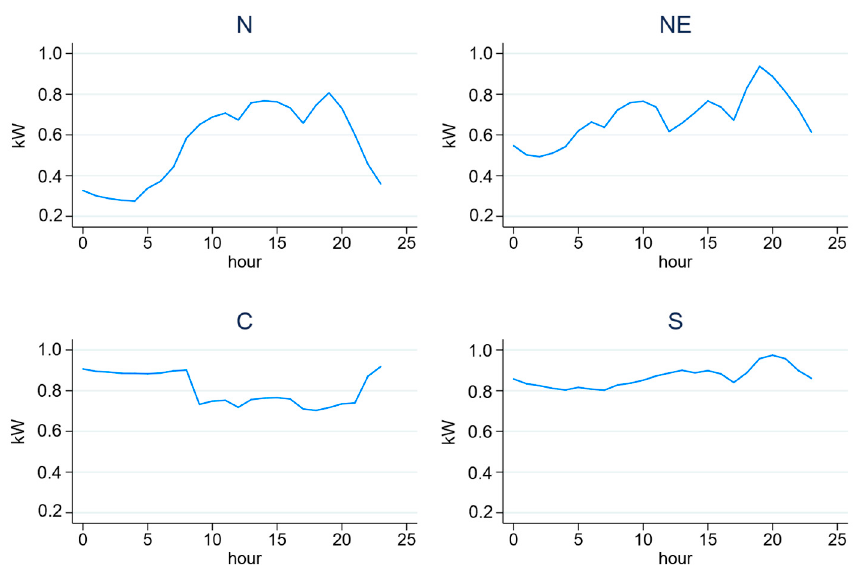
Figure A2. Hourly average load profile of SGS customers in Northern region (N), Northeastern region (NE), Central region (C), and Southern region (S).